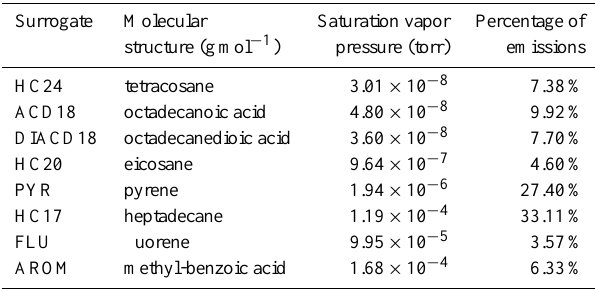
Table 1. Properties of the different surrogate primary SVOC